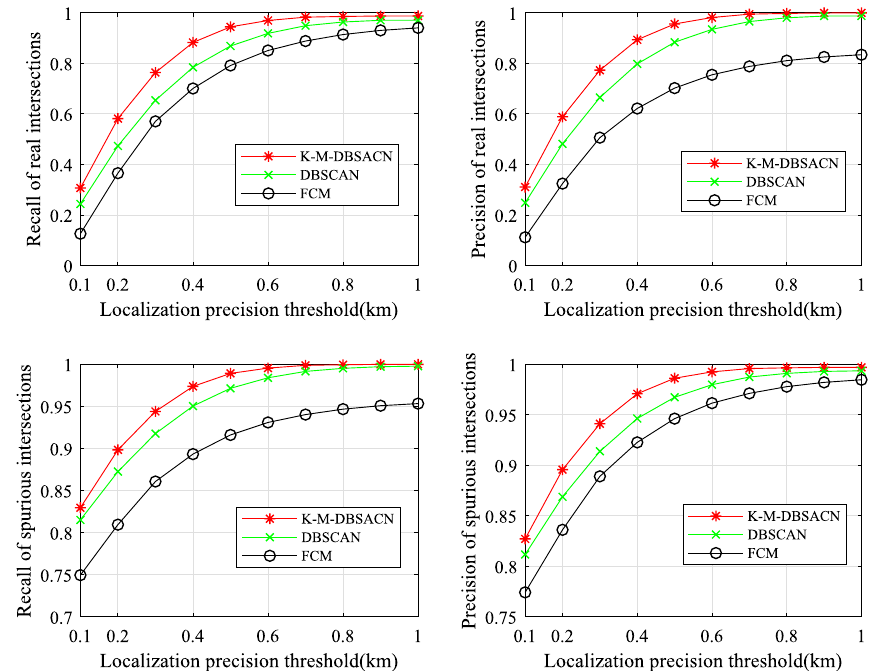
Fig. 10 Comparison of recall and precision versus the localization precision